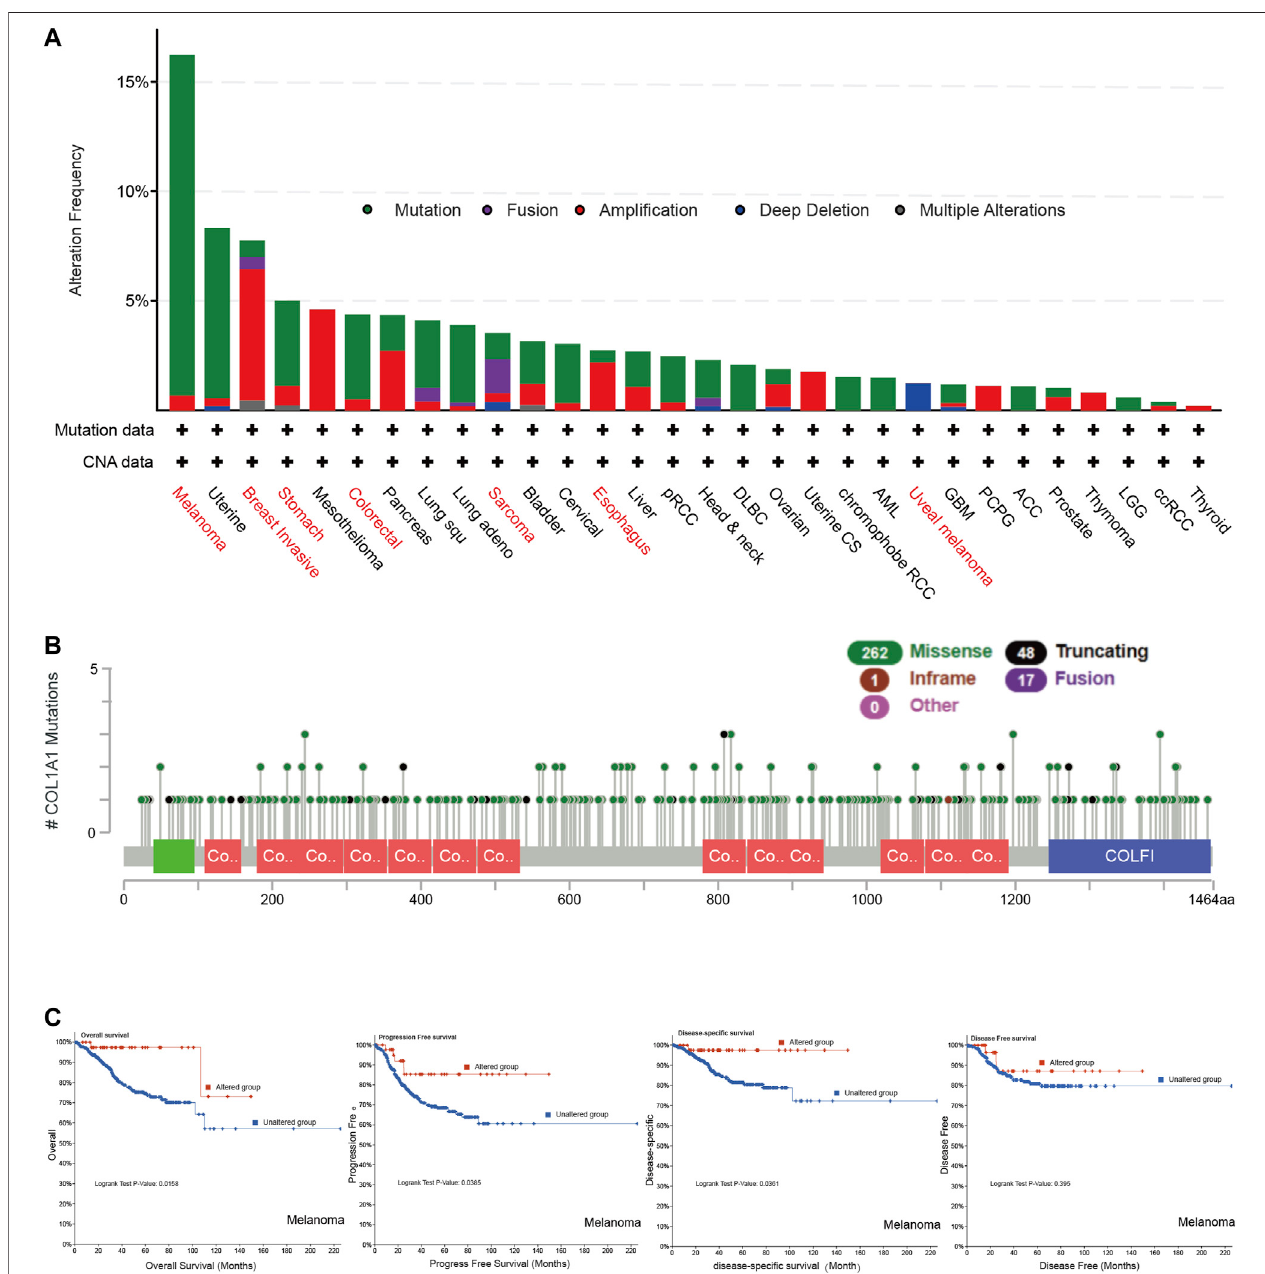
FIGURE 3 | (A) Genetic alteration type and frequency of COL1A1 in different tumors of TCGA by cBioportal. (B) Mutation sites of COL1A1 , which contain 262 missense, 48 truncating, 17 fusion, and 1 inframe mutations. (C) COL1A1 alteration status and overall, progression-free, disease-speci fi c, and disease-free survival of